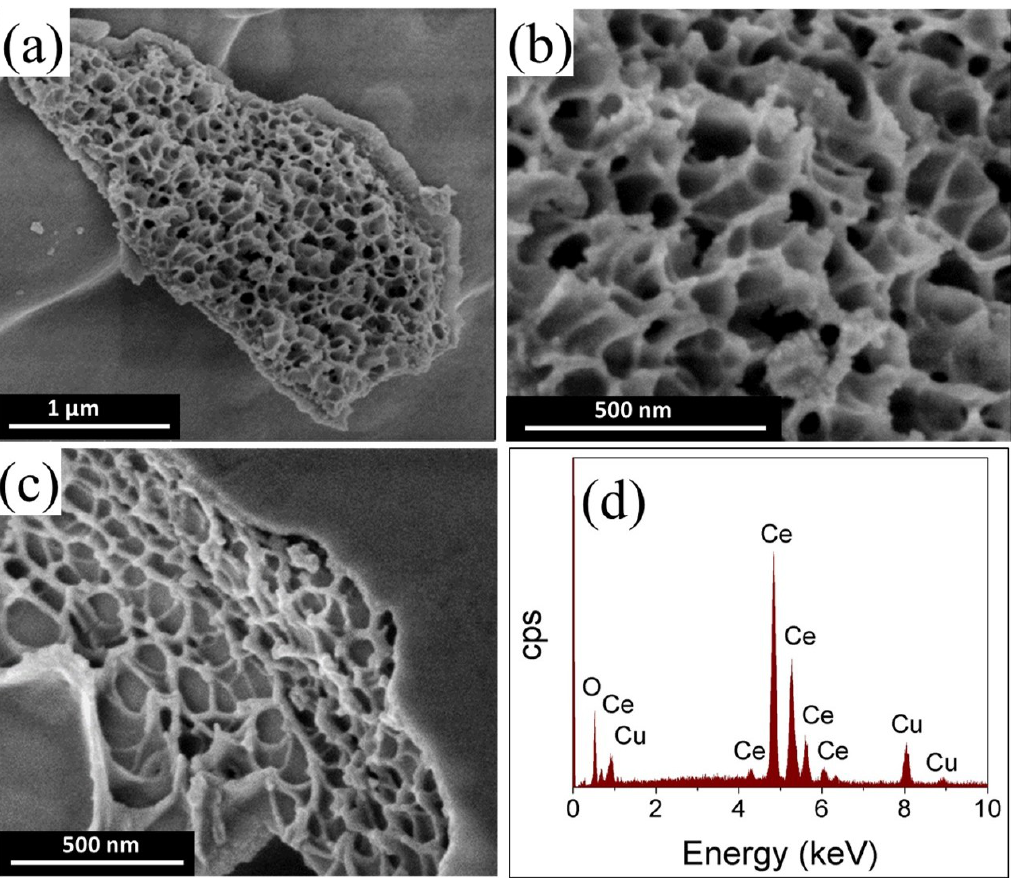
Figure 1. SEM micrograph images of ( a , b ) CeO 2 ; ( c ) 6% CuO-CeO 2 prepared by the solution combustion method, and ( d ) The EDX spectrum of 6% CuO-CeO 2 , showing the Cu and Ce elements.